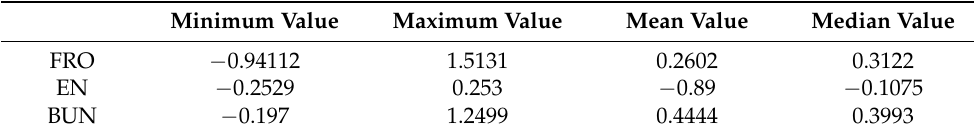
Table 13. GTWR Regression results of commercial land category 2.